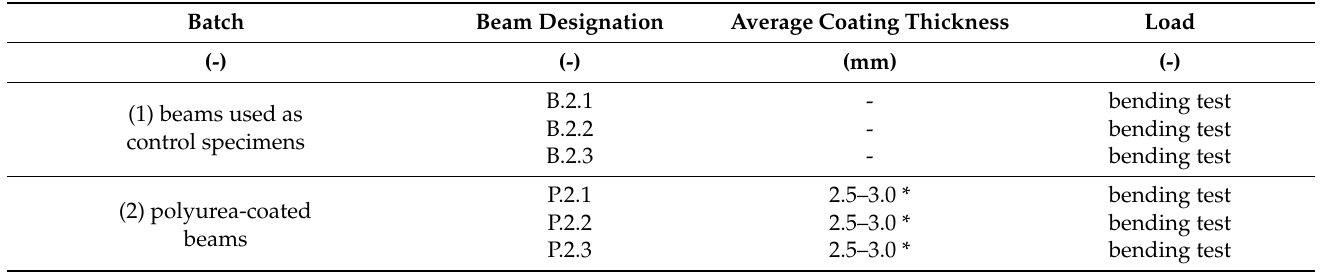
Table 5. Description of test specimens.